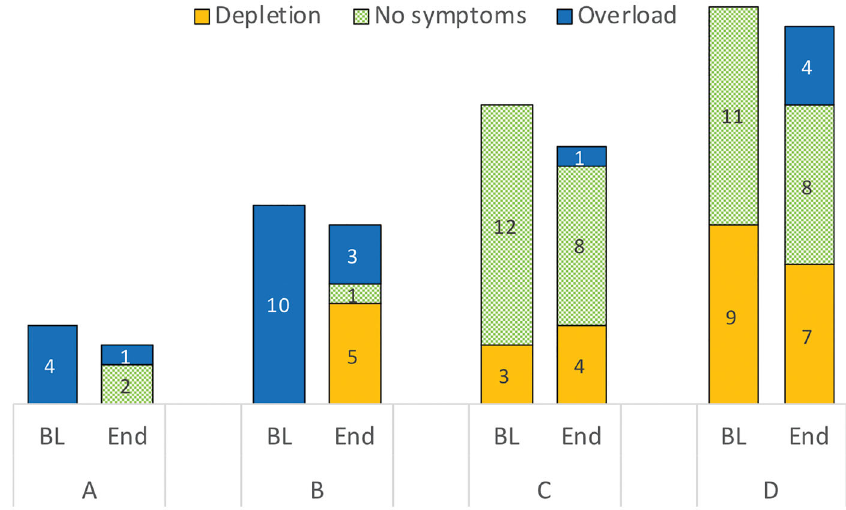
Figure 3. Comparison of distribution of pre-dialysis fluid symptom status in each group (frequencies), at baseline (BL) and at end-of-study